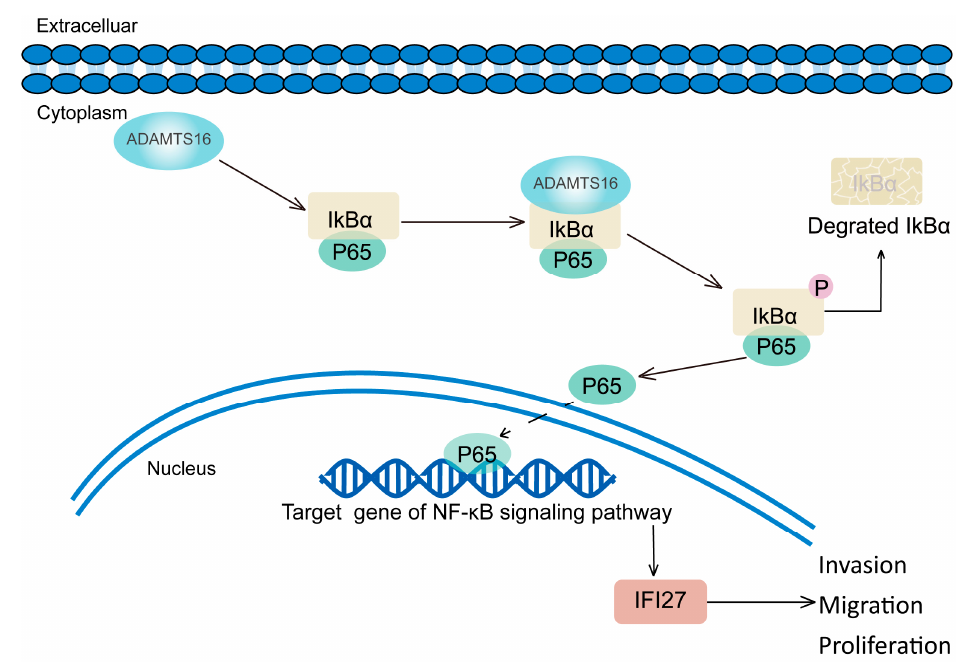
Figure 6. Model for the mechanism of ADAMTS16 in the development of GC.